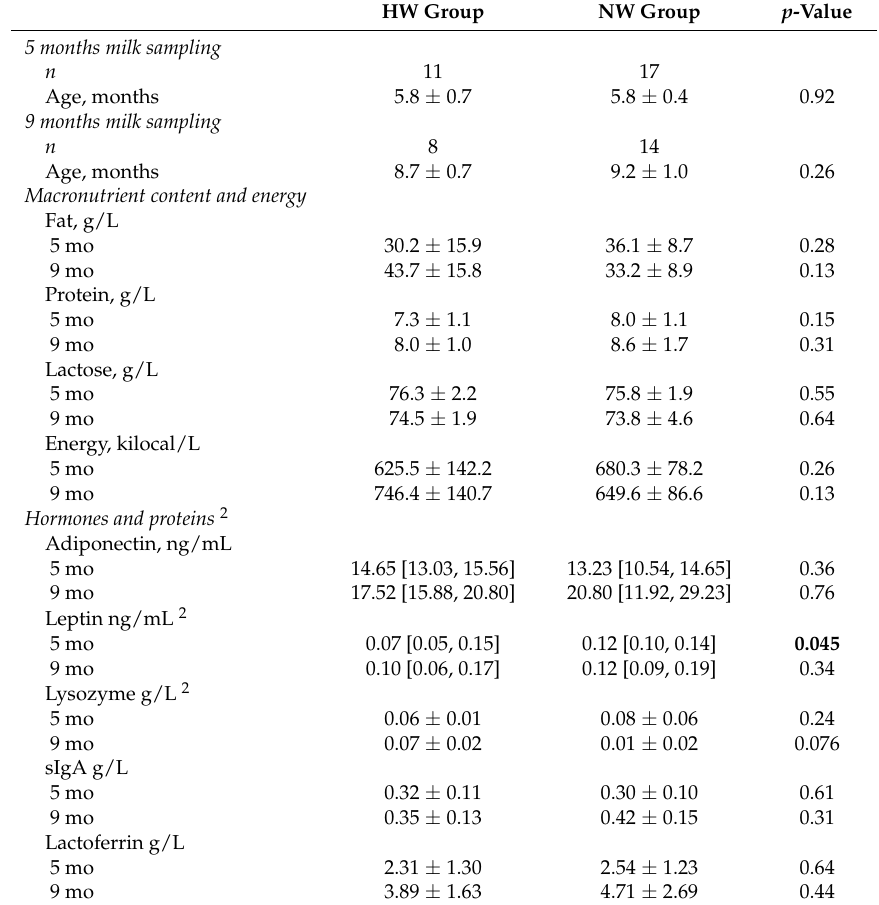
Table 4. Macronutrient, hormone and protein content of human milk at 5 and 9 months, in the high weight gain and normal weight gain group 1